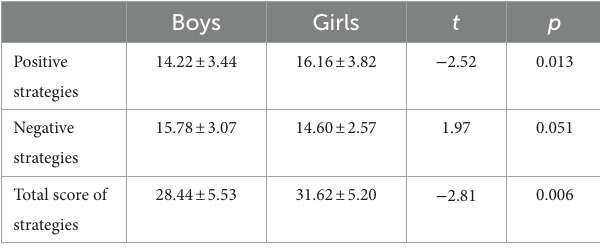
TABLE 3 Results of gender difference on children’s peer conflict resolution